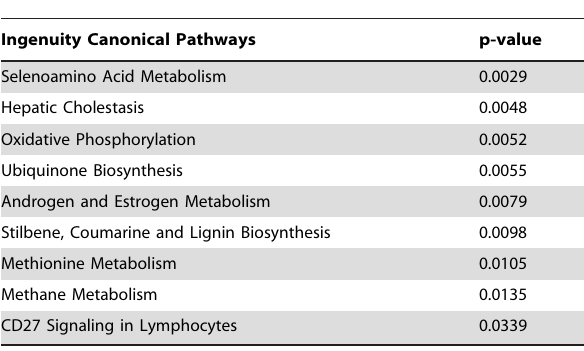
Table 2. Pathway analysis of gene expression in morphologically normal prostate tissue in men who have high dietary intake of fish (n= 26) compared with low dietary fish intake (n =58).